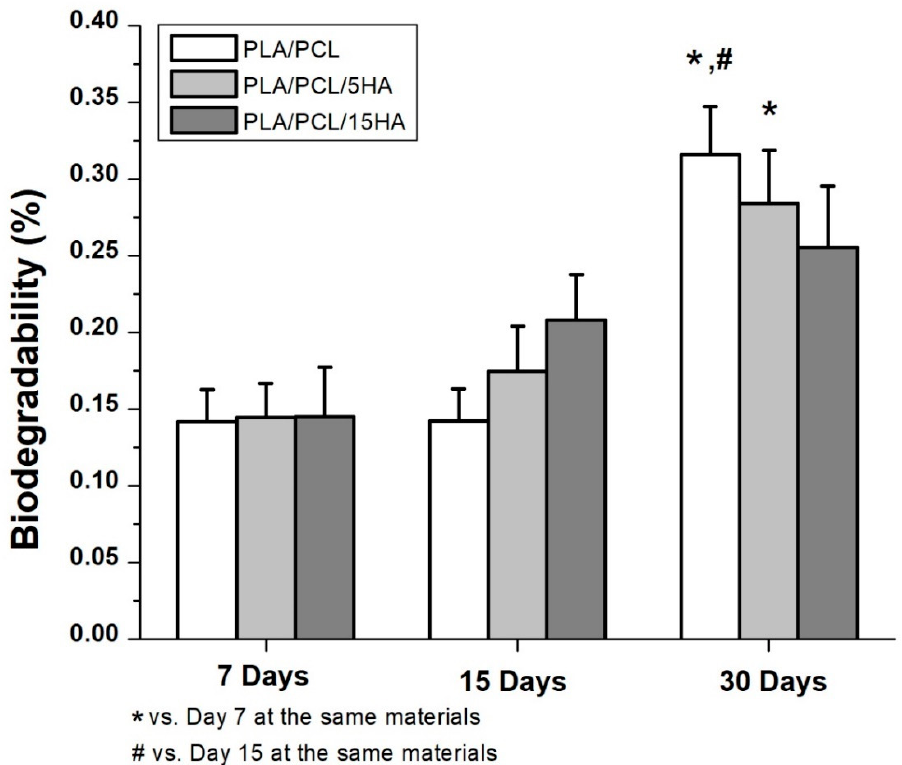
Figure 10. Biodegradation percentage of the composite specimens .